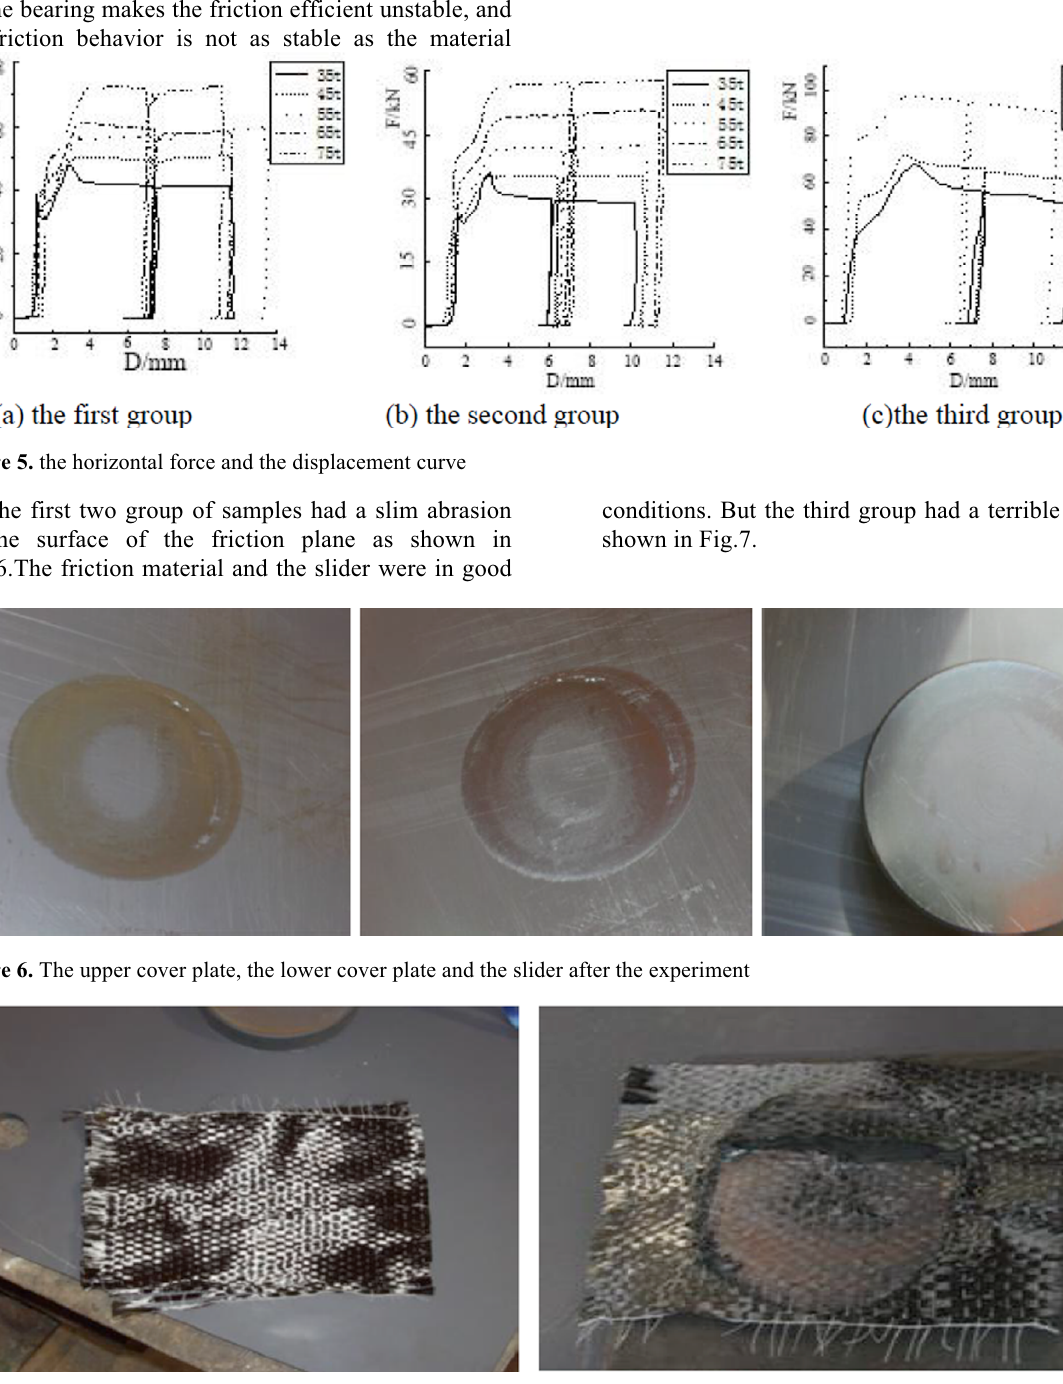
Figure 7. the carbon fiber cloth before the experiment and after the experiment The friction efficient of the MoS2 material can be tested from the respective restoring force curve as shown in